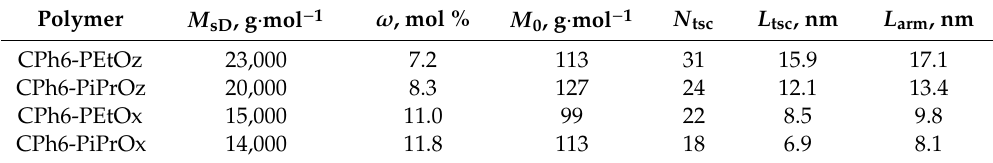
Table 2. Molar masses and structure characteristics of synthesized polymer stars.